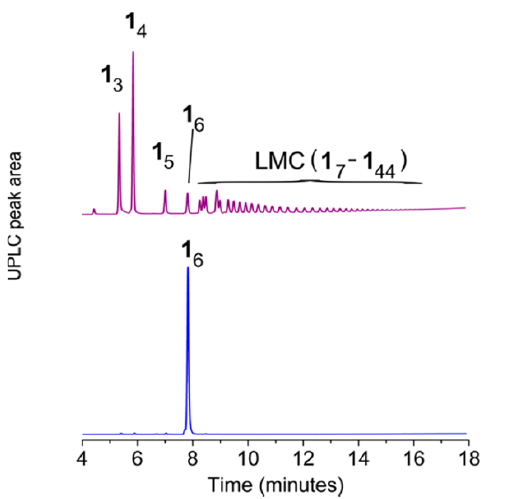
Figure 32. Mass spectra of dithiol amphiphiles from unstirred (top) and stirred (bottom) solutions after exposure to an oxidant for one week. Reprinted with permission from [138]. Copyright (2017) American Chemical Society.